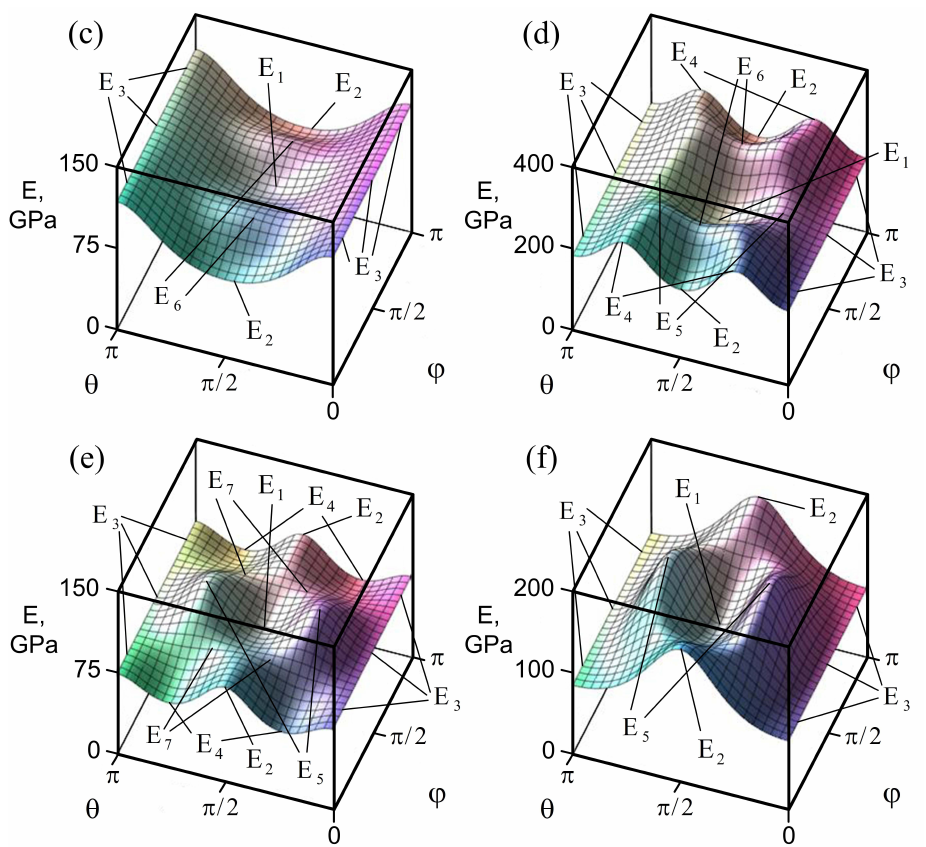
Figure 2. Young’s modulus surfaces for rhombic crystals related to one of six zones: AgTlSe ( E 1 > E 2 > E 3 ) ( a ), CaCO 3 ( E 1 > E 3 > E 2 ) ( b ), Ga ( E 3 > E 1 > E 2 ) ( c ), Ni 3 B ( E 3 > E 2 > E 1 ) ( d ), ZnSb ( E 2 > E 3 > E 1 ) ( e ) or TbF 3 ( E 2 > E 1 > E 3 ) ( f